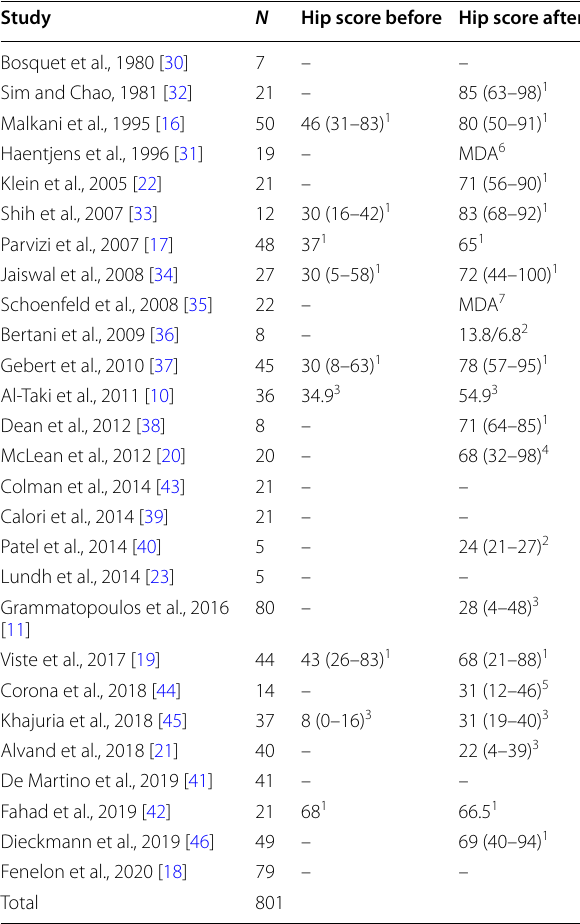
Table 4 Hip scores: 1 Tumor Society Score [49]; 3 Extremity Salvage Score [50];